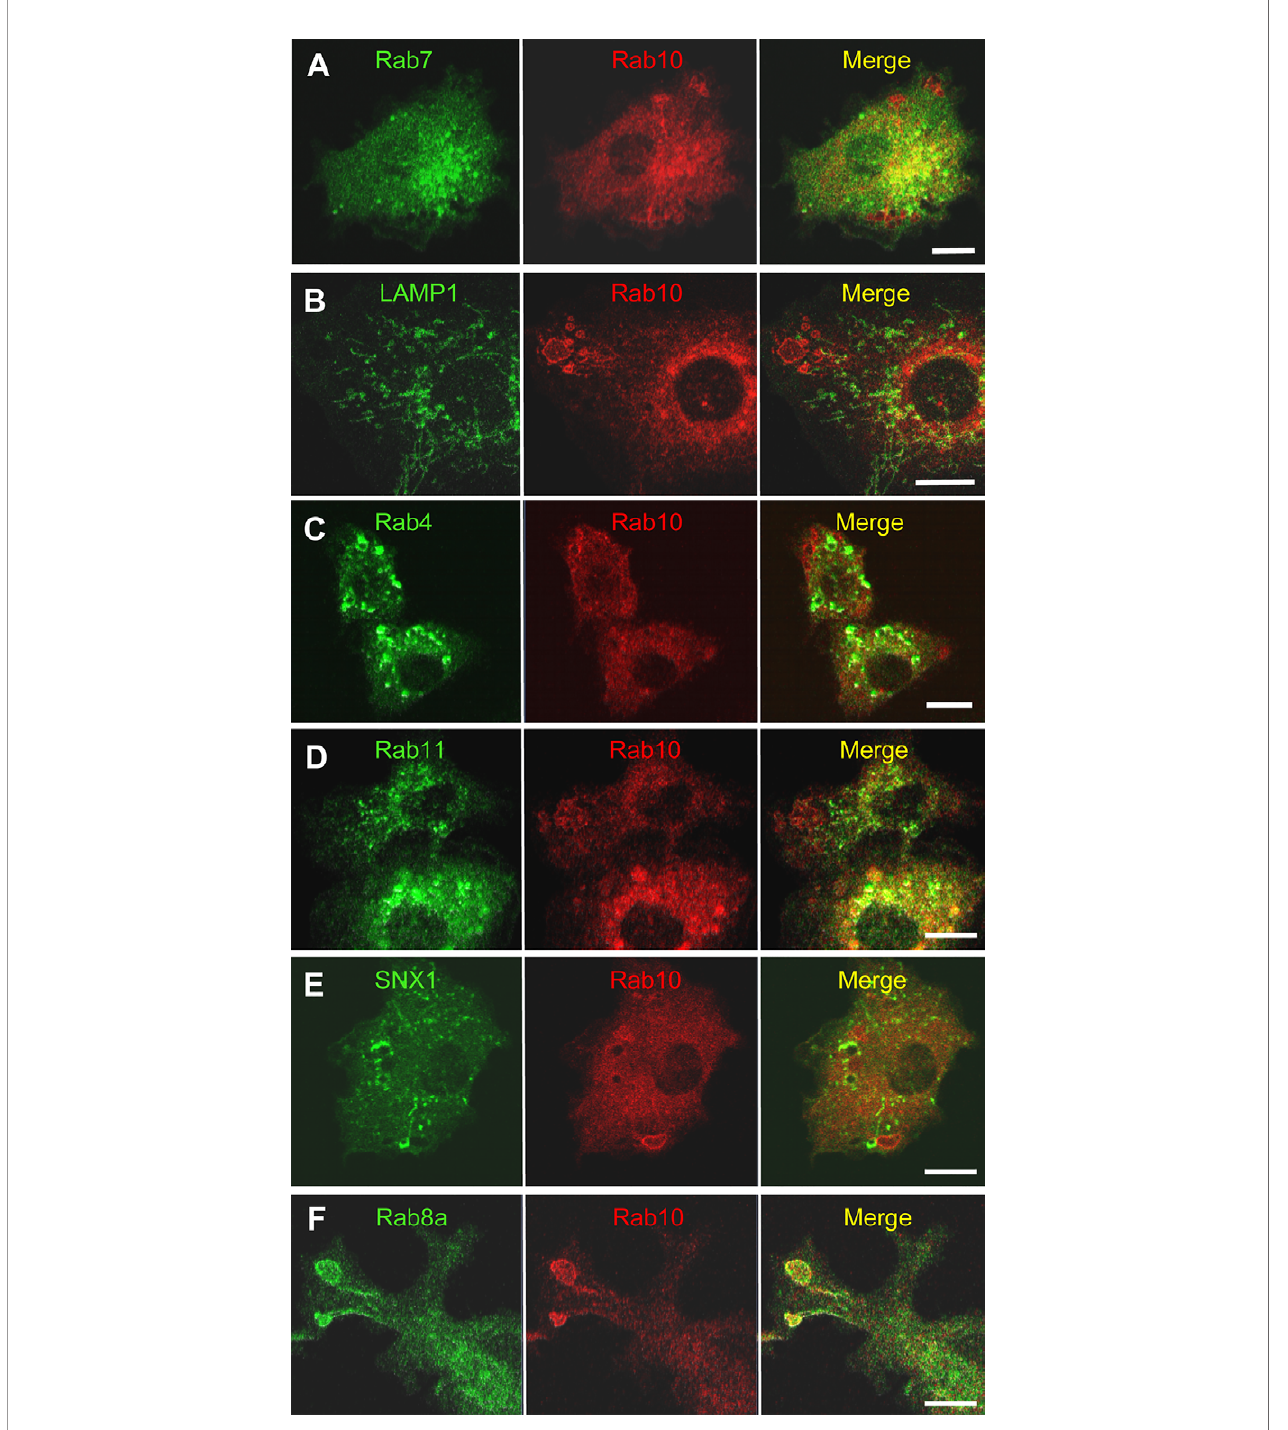
FIGURE 7 | Rab10-positive premacropinosomes and tubules are distinct from conventional degradative endocytic or recycling pathways. Rab10-positive premacropinosomes and tubules are not labeled with the late endosome/lysosome markers, Rab7- (A) or LAMP1 (B) . The recycling endosomal markers, Rab4 (C) , Rab11 (D) , and sorting nexin 1 (SNX1) (E) are faintly observed in Rab10-positive premacropinosomes and tubules, although they are only transiently recruited to the Rab10-negative conventional macropinosomes. Only Rab8a colocalized with Rab10 in the premacropinosomes and extending tubules (F) . All scale bars = 10 m m. The corresponding movies are available in the ( Supplementary Material Movies 10 – 14